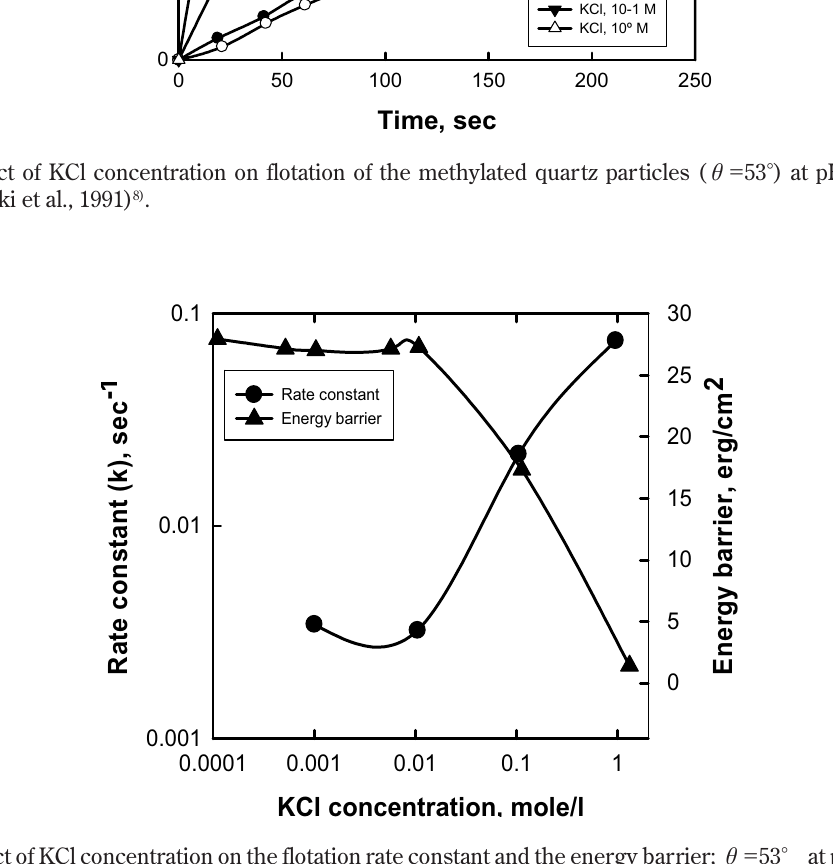
Fig. 4 The effect of KCl concentration on the flotation rate constant and the energy barrier; θ= 53 ° at pH 6.1 to 6.5 (after Laskowski et al., 1991) 8)